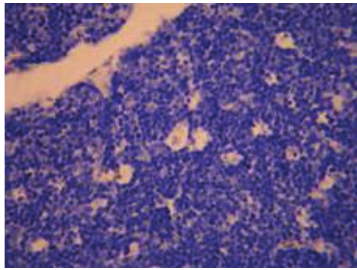
Figure 10: Sham-operated group—28d in OJ experiment thymus (negative TUNEL × 200).